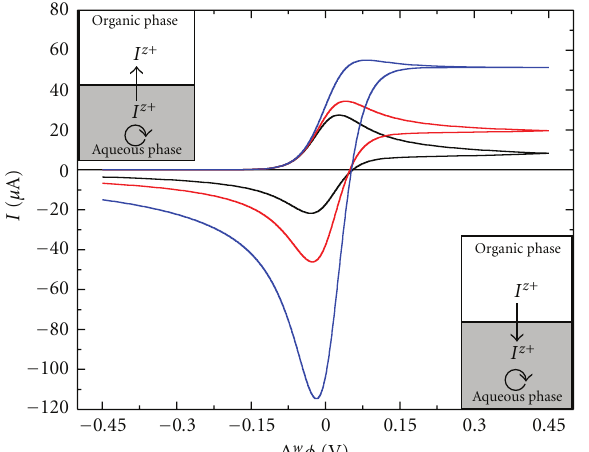
Figure 3: Simulated voltammograms in di ff erent conditions of mass transport. Quiescent solution (black line) with forced hydro- dynamic condition applied in aqueous phases: ν W x = 1 × 10 − 3 cms − 1 (red line) and ν W x = 3 × 10 − 3 cms − 1 (blue line). Δ w o φ o (cid:3) I z + = 0 . 00V. Other parameters are as in Figure 2.